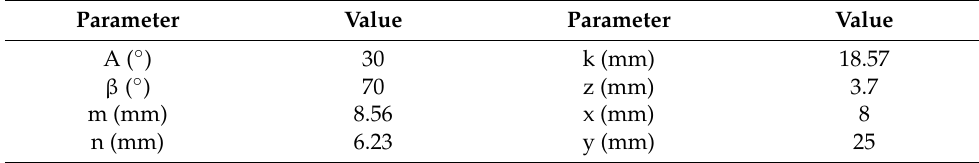
( b ) Figure 3. The three-dimensional structure of self-circulating casings. ( a ) SRCC0.36. ( b ) SRCC0.72. 2.2. Numerical Simulations The grids were generated using the IGG/Autogrid5 module in NUMECA-16.1 soft- ware. The impeller passages adopted the O4H grid topology, and the butterfly grid was utilized for the blade tip clearance. The H-grid topology was adopted for the inlet and